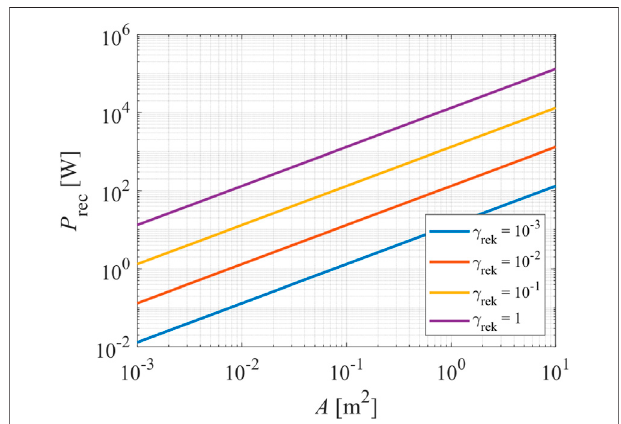
FIGURE 5 | The theoretically achievable O-atom density in a plasma reactor of fully recombinative surfaces of surface area 0.1, 1, 10, 100 dm 2 versus the discharge